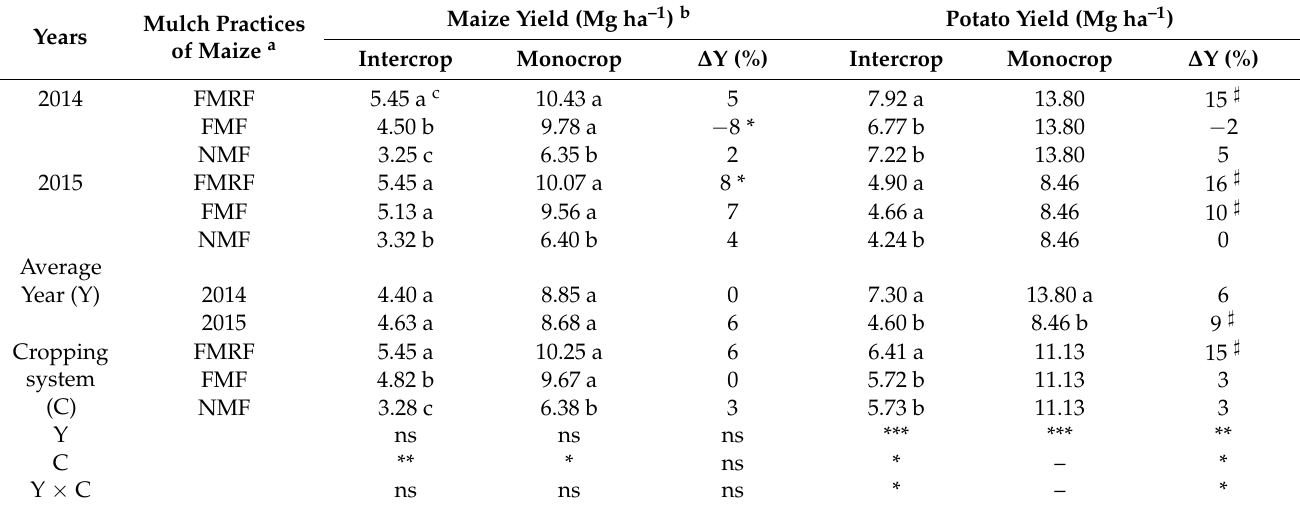
Table 2. Yields of maize and potato crops in the intercropping compared with monocrop in 2014–2015.